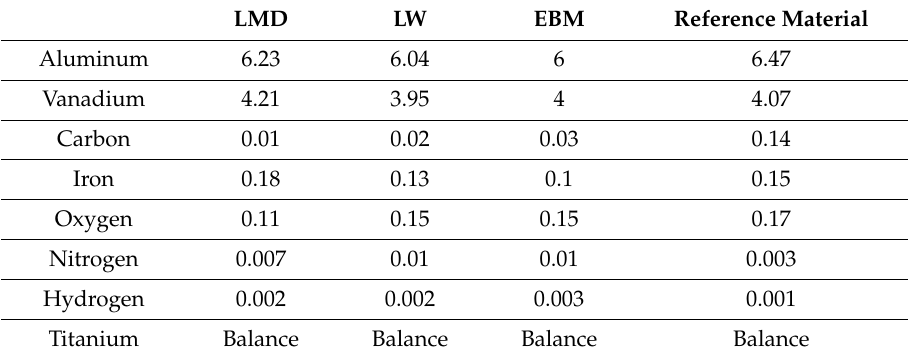
Table 4. Chemical specifications of the workpiece materials. Data are in weight %.